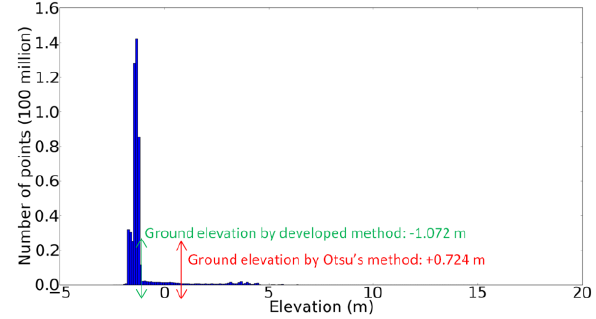
Figure 2. Histogram of points’ elevation